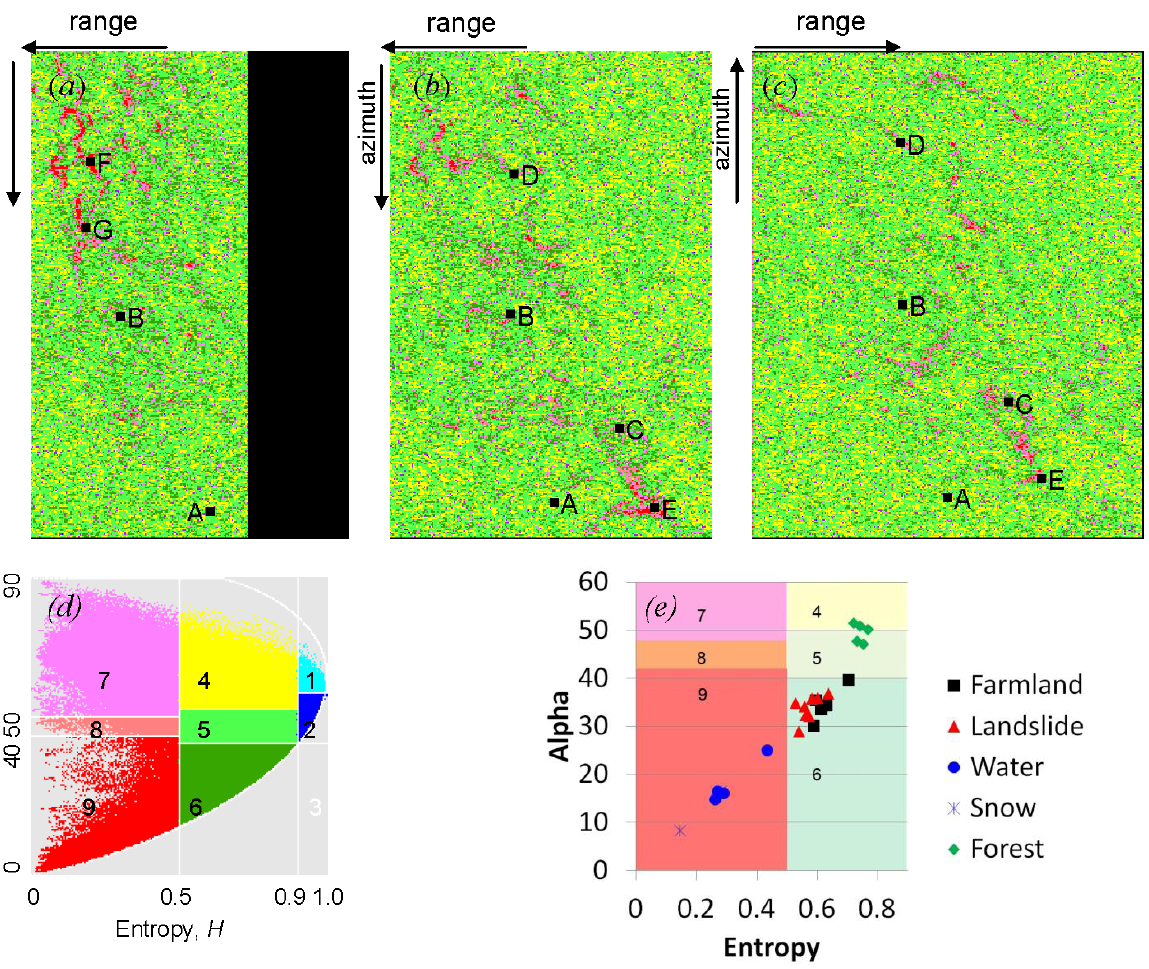
Figure 4. Unsupervised classification image using H-   segmentation with eight looks in azimuth for ( a ) 19 May 2006, ( b ) 24 November 2008, and ( c ) 4 June 2009; ( d ) Partitioning and color legend, with numbers referring to the region described in Table 4; ( e ) H-    plot for each area shown in Table